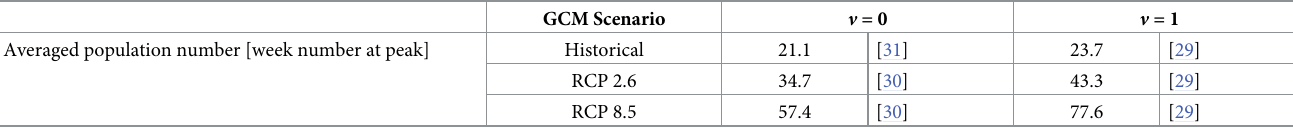
Table 4. Peak population number on averaged dynamics with Global Climate Model (GCM) and the peak